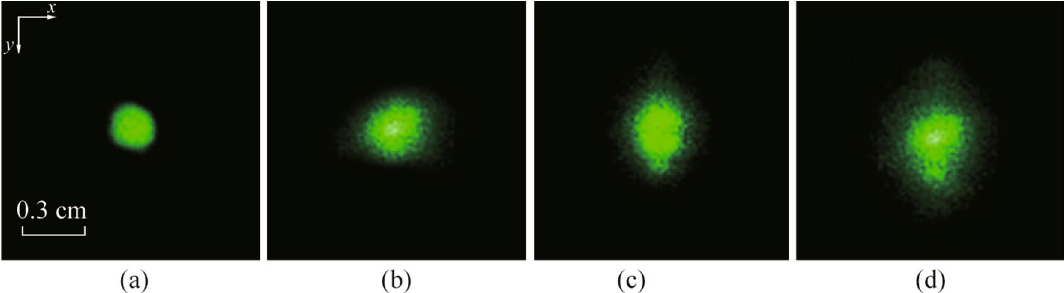
Fig. 3 Typical image of laser spots. a Undistorted beam without surface wave turbulence. b Distorted beam at the water depth of 12 mm. c Dis- torted beam at the water depth of 8 mm. d Distorted beam at the water depth of 4